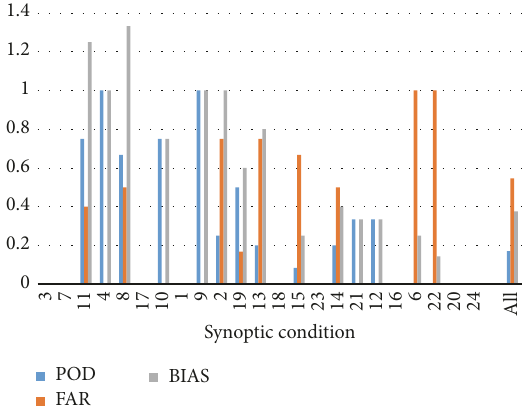
Figure 15: Statistical scores for each synoptic condition (1–24) and considering all cases irrespective of the synoptic condition (shown as All). Synoptic conditions are ranked as explained in Figure 13.